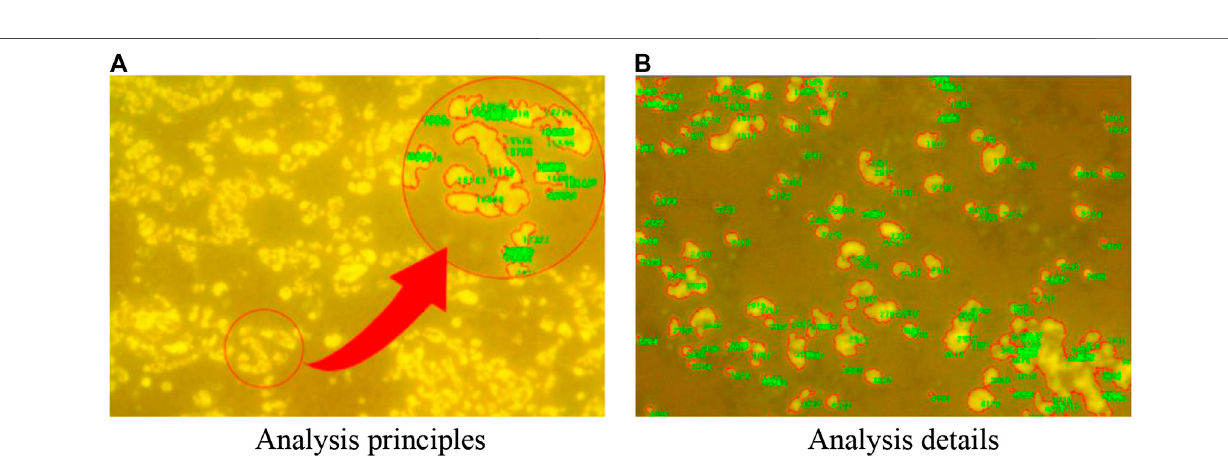
Frontiers in Materials |